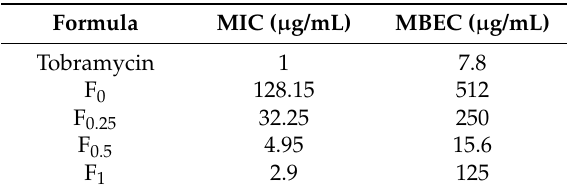
Table 3. The antimicrobial effect (MIC) (µg/mL) and the minimum biofilm eradication concentration (MBEC) (µg/mL) of tobramycin, PLGA, and LMWC-PLGA NPs.